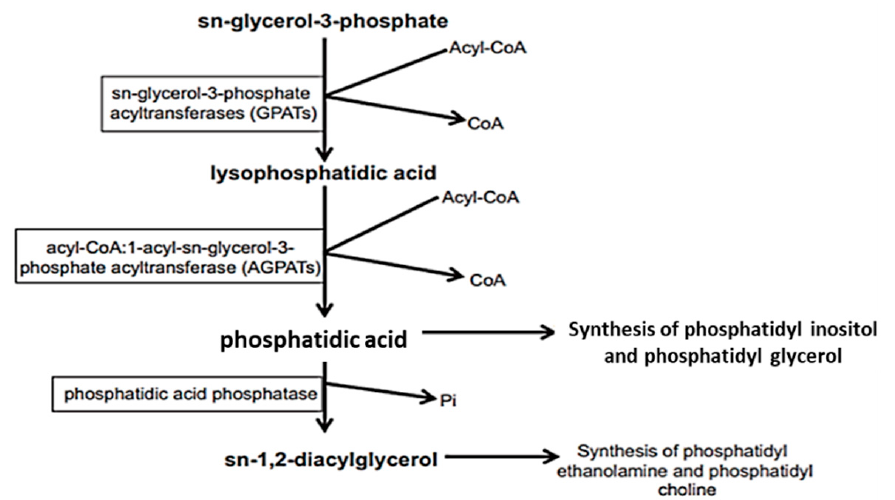
Figure 2. De novo synthesis of sn -1,2-diacyl glycerophospholipids [11]. From sn -glycerol-3-phosphate to the formation of sn -1,2-diacylglycerol (DAG), several enzymes are involved: GPATs, AGPATs, and phosphatidic acid phosphatase. DAG is the precursor of PE and PC whereas PI and PG are produced through phosphatidic acid. Reprinted with permission from Ref. [11]. Copyright